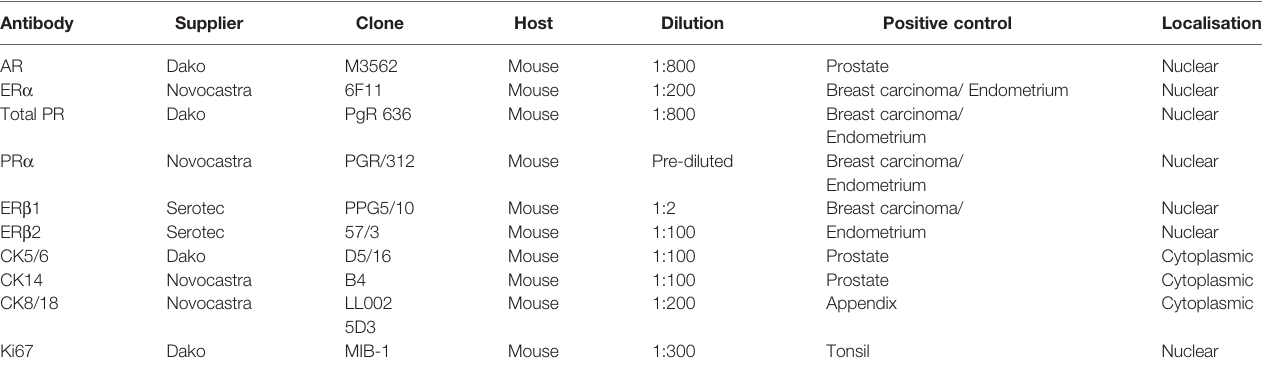
TABLE 1 | Details of the studied